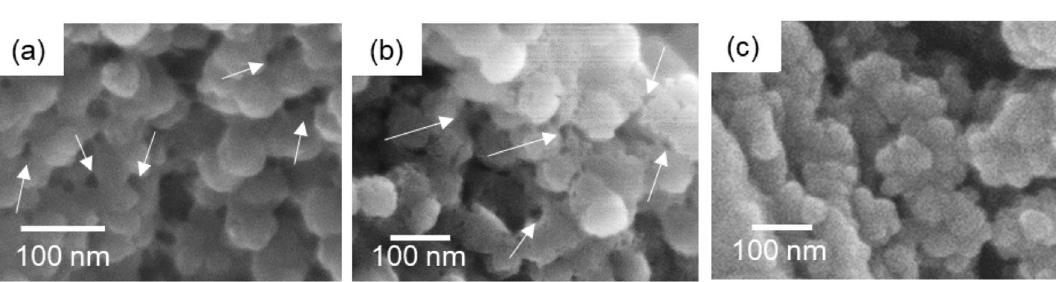
Figure 2. SEM images of silica particles in the surface layer of an immature rice husk after treatment with cellulase ( a ) and after treatment with the ionic liquid ( b ), and after calcination ( c ). White arrows indicate holes that were formed after dissolution of the